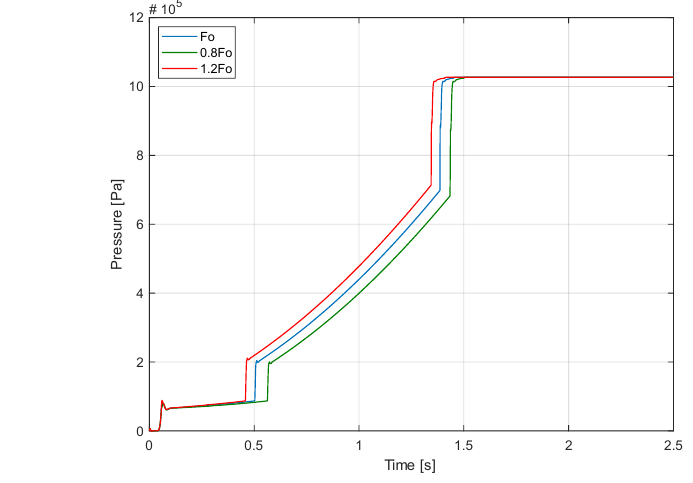
Figure 14 – Influence of the preload force Fo of the spring (c) on the process of pressure modulation Рис. 14 – Влияние усилия преднатяга Fo пружины (c) на процесс модуляции Слика 14 – Утицај силе преднапрезања Fo опруге (c) на процес